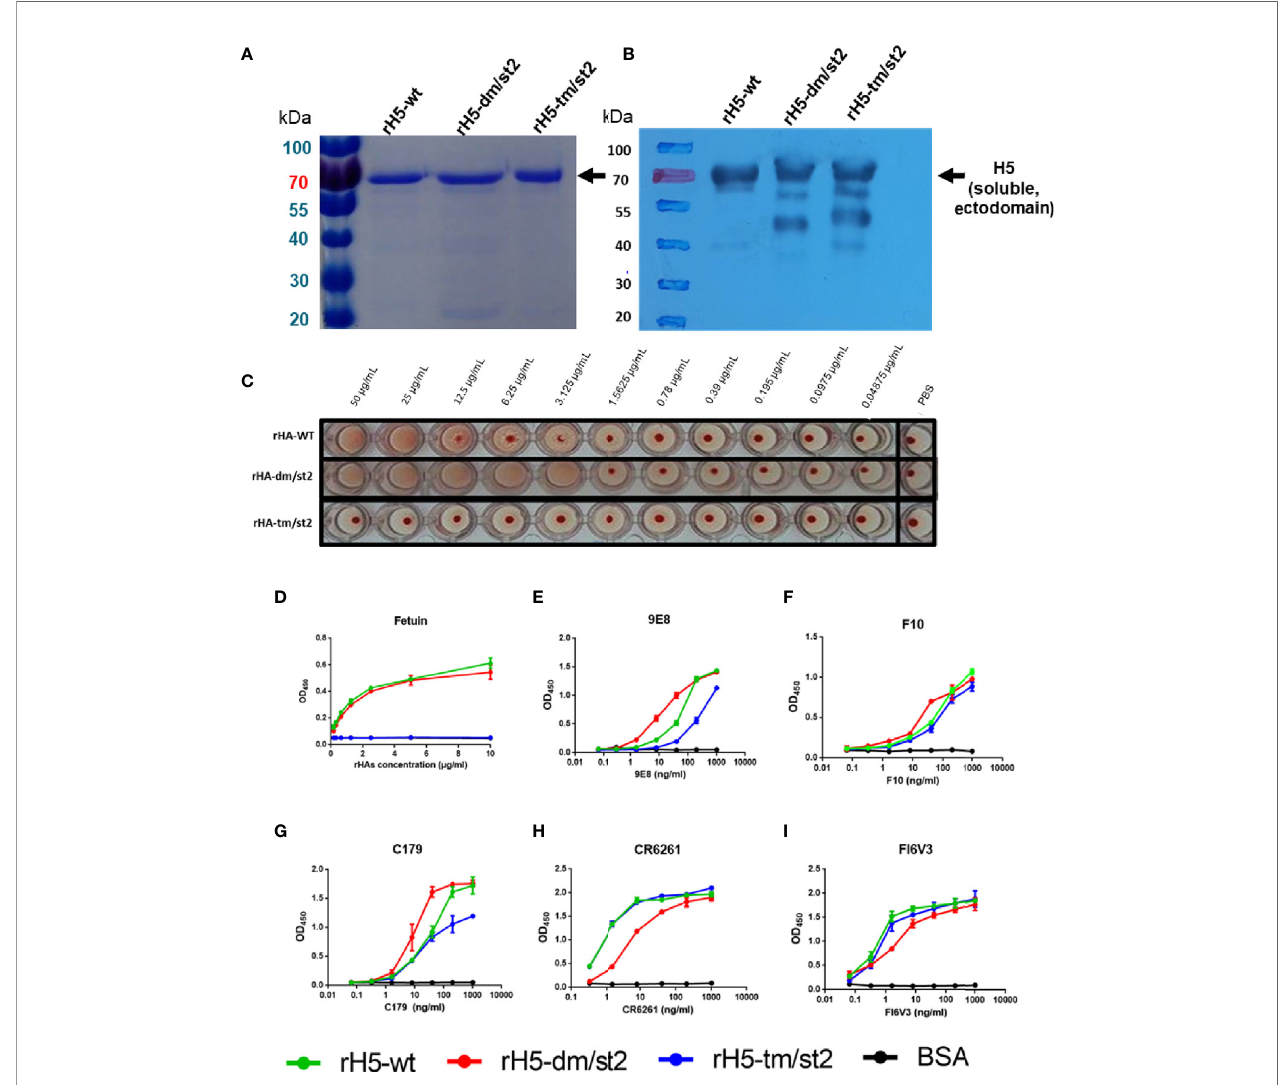
FIGURE 1 | Characterizations of rH5-wt, rH5-dm/st2, rH5-tm/st2 proteins. The puri fi ed rH5-wt, rH5-dm/st2, and rH5-tm/st2 proteins were characterized by (A) SDS-PAGE and (B) western blotting. The sialic acid bindings of rH5 proteins were determined by (C) RBC hemagglutination and (D) fetuin binding assay. Bindings of rH5-wt, rH5-dm/st2, and rH5-tm/st2 proteins with (E) 9E8, (F) F10, (G) C179, (H) CR6261, and (I) FI6V3 mAbs were determined by